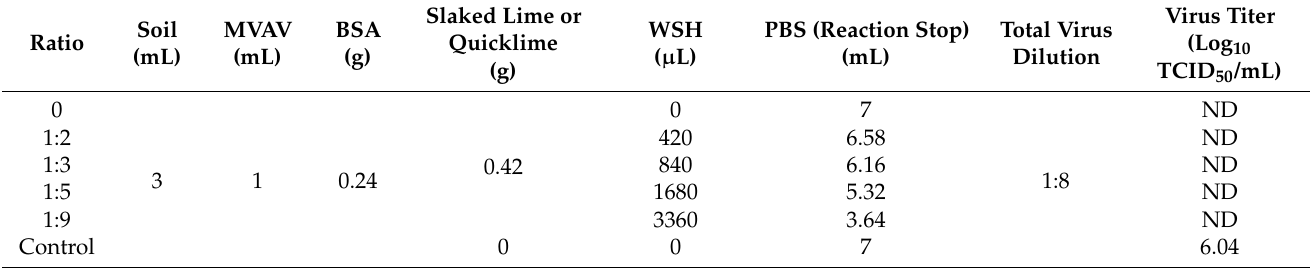
Table 2. Setup and results of lime/water ratio experiments. WSH (water with standardized hardness level) was used in the experiments. The water content has no influence on the efficacy of the liming. No infectious virus was detected after disinfection in any soil type, independent of the water content. The limit of detection is 1.7 Log 10 TCID 50 /mL. Control value is the average of virus concentrations in TS and MS of